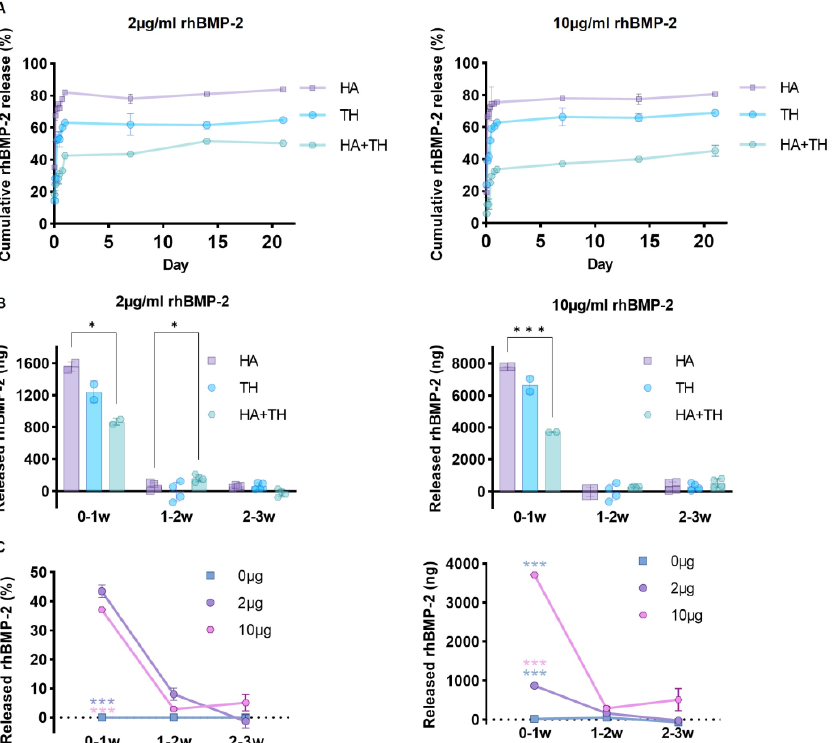
Figure 1. In vitro release kinetics according to the composition of the carrier and the concentration of rhBMP-2. ( A ) The release pattern of 2 µ g and 10 µ g rhBMP-2 from HA, TH, and HA + TH using ELISA. Mixing rhBMP-2 at a high concentration with HA + TH as a carrier delayed the release of rhBMP-2. ( B ) The amount of rhBMP-2 released at intervals of 0 – 1, 1 – 2, and 2 – 3 weeks. From 0 to 1 week, HA and TH released much more rhBMP-2 than HA + TH. ( C ) Concentration-dependent re- lease patterns of rhBMP-2 from HA + TH. Although there was a difference in the amount of rhBMP- 2 released depending on the rhBMP-2 concentration, the pattern was almost the same. Most of the